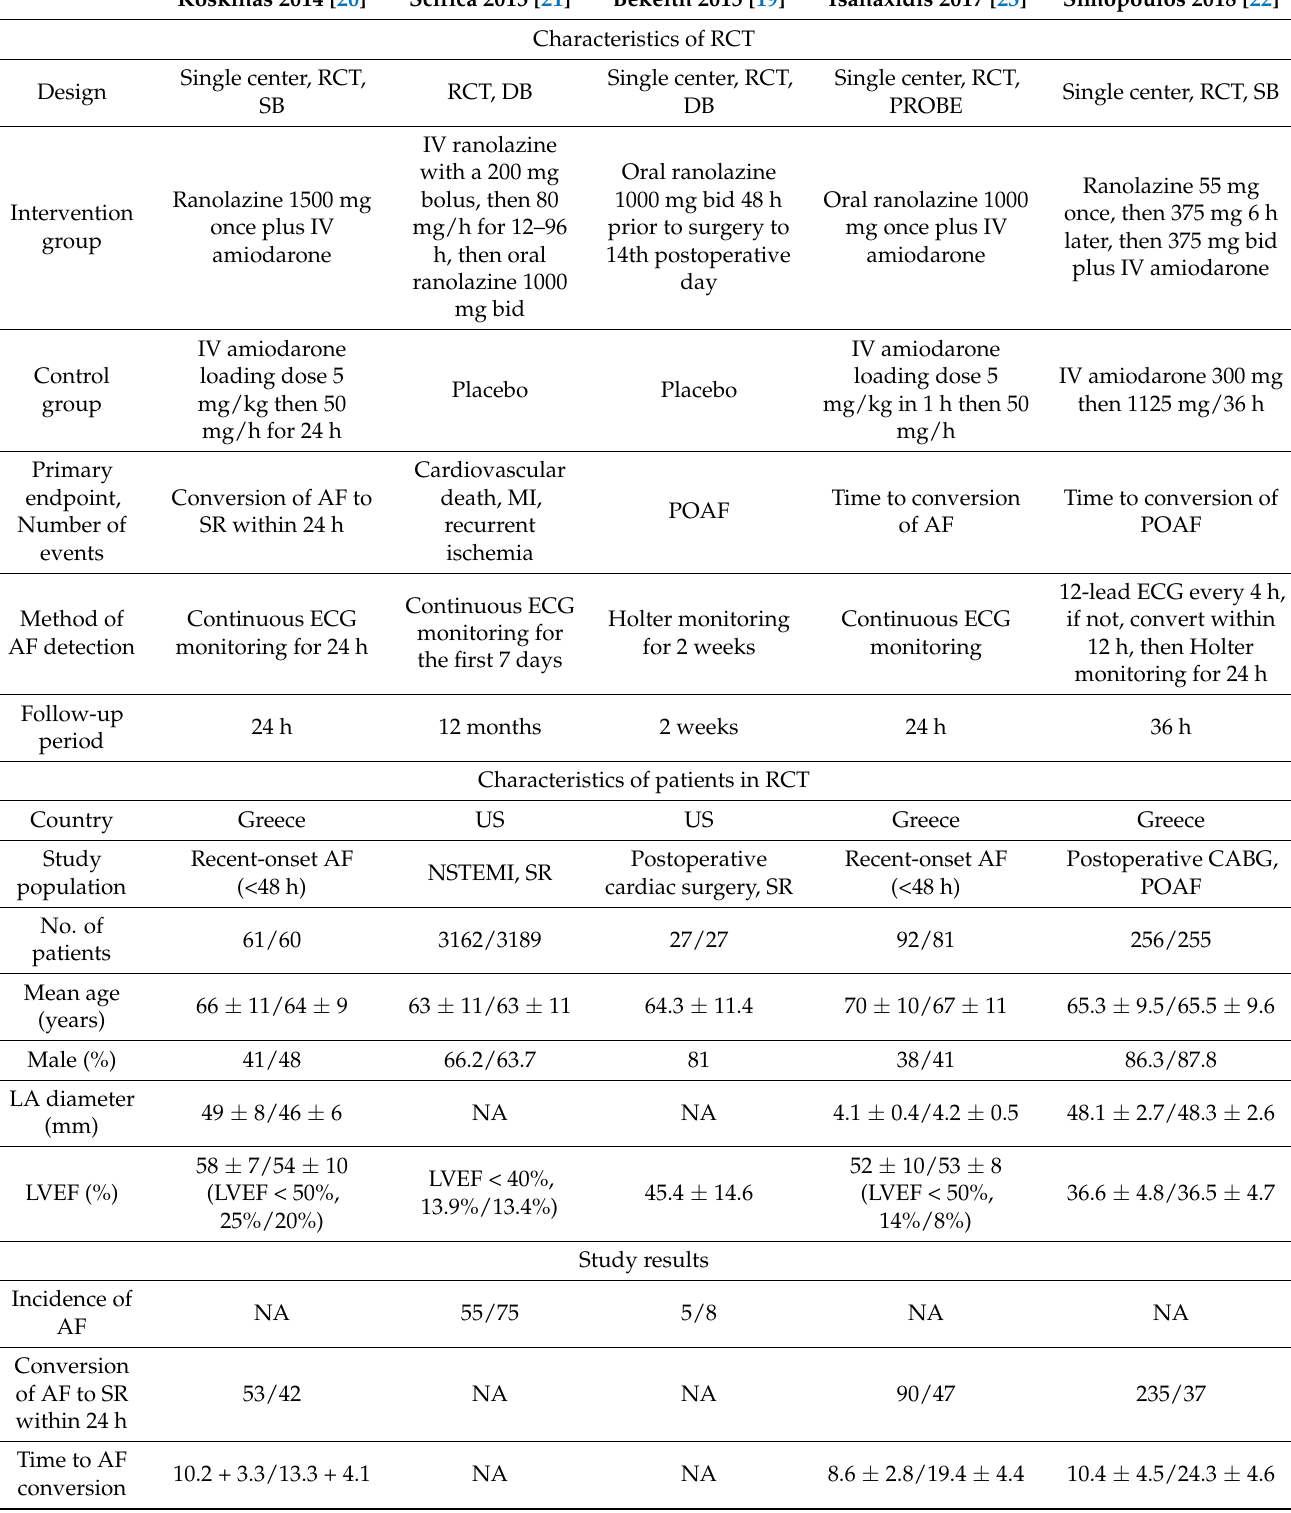
Table 1. The characteristics and quality assessment of the included